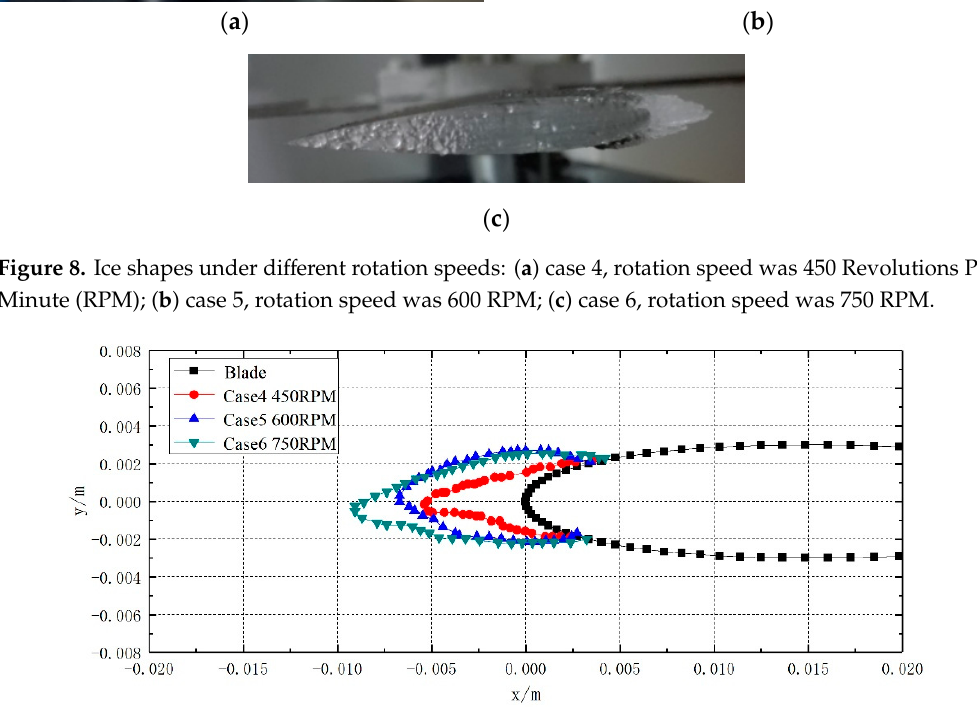
Figure 9. Comparison of ice shapes under different rotation speeds.